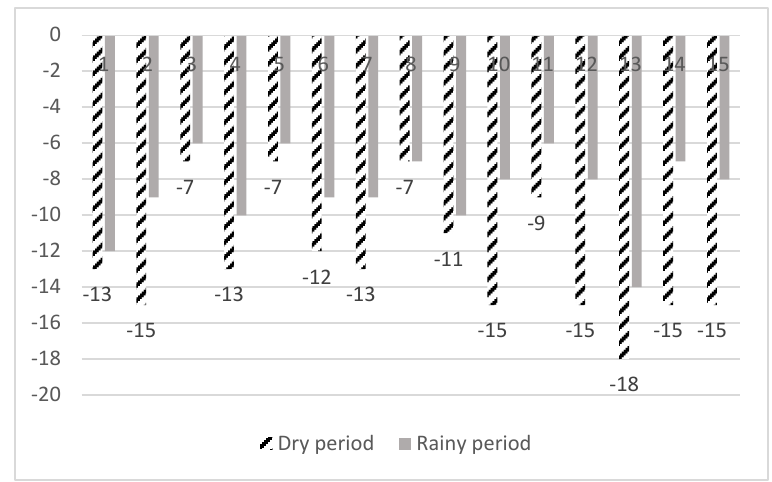
Figure 5. Scores of evaluations for the 15 fountains in dry and wet periods.